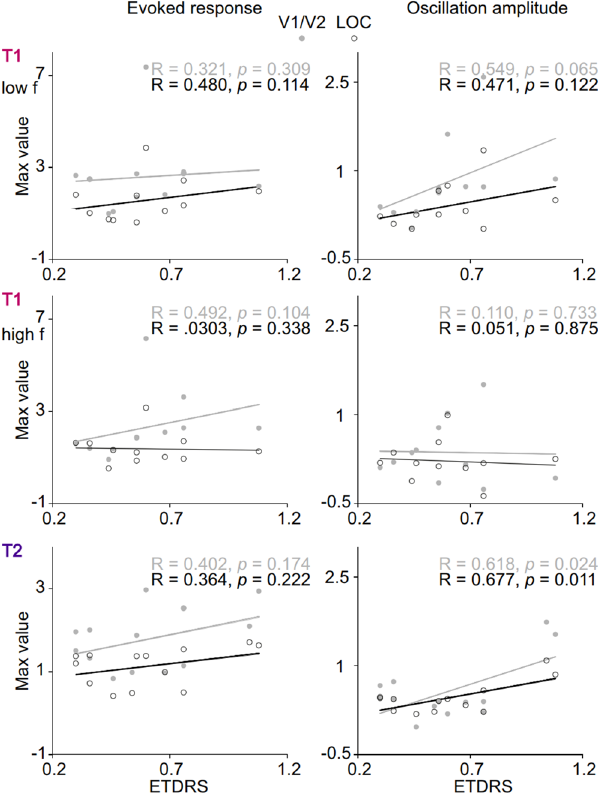
Figure 6. Oscillation amplitudes correlate with depth of amblyopia in the change detection task. Correlation of ERs and oscillation amplitudes with the depth of amblyopia (Pearson’s correlation tests, Bonferroni corrected with 6 tests) as indexed by the visual acuity of the AE (ETDRS values). The correlation was based on maximum peak values of the FE-AE difference in the ERs and theta-alpha oscillations between 0.1 and 0.4 s. Filled grey points denote V1/V2 parcels selection, and open black points lateral occipital cortex (LOC) parcels